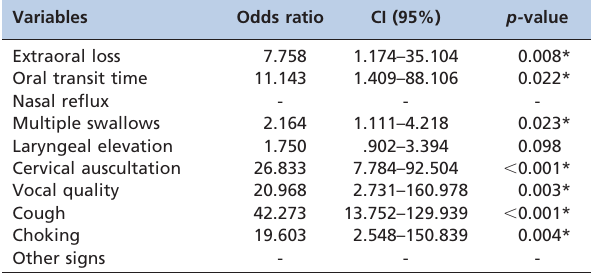
Table 4 - Logistic regression (univariate analysis) results based on independent dysphagia risk variables.